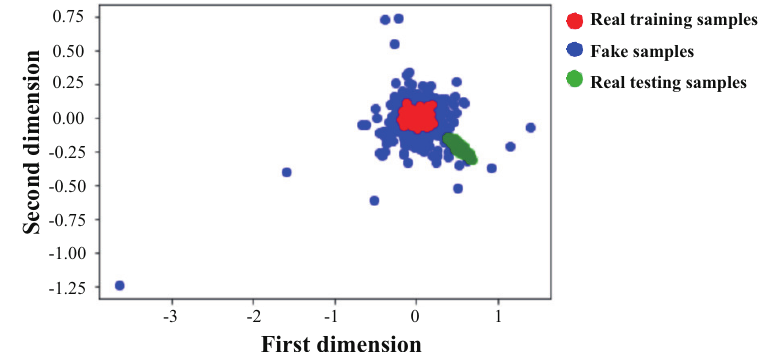
Figure 11. Feature distribution based on the auxiliary classes